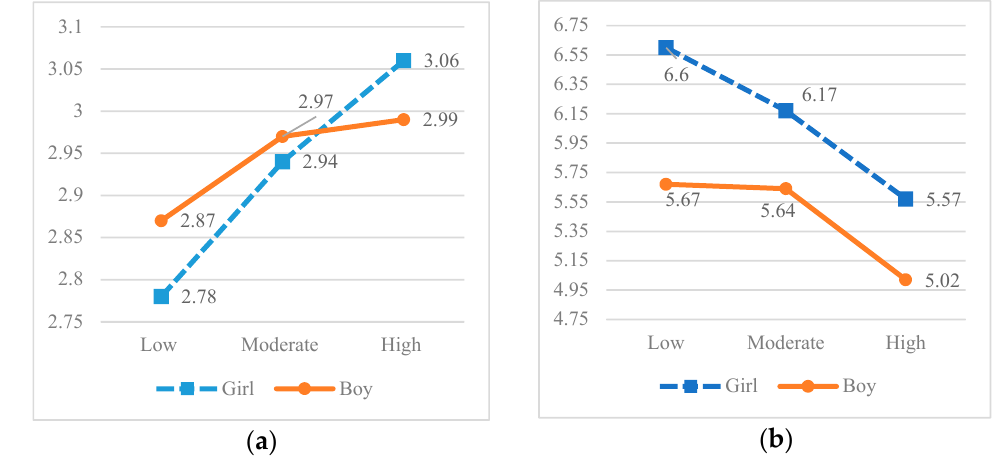
Figure 1. ( a ) Interaction between avoidant communication with the mother, degree of cybervictimization and gender; ( b ) Interaction between academic competence, degree of cybervictimization and gender.